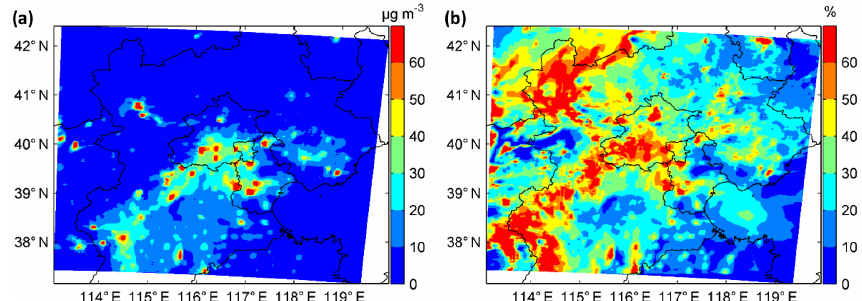
Figure 9. (a) Simulated PM 2 . 5 concentrations difference between December of 2015 and 2014. (b) PM 2 . 5 fractional difference.